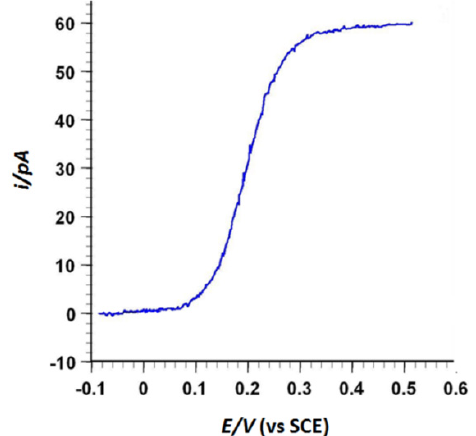
Figure 2. Steady-state voltammogram of the AFM-SECM-electrode in aqueous solution containing 1 mM ferrocenedimethanol and 0.1 M KH traces are superimposed. The potential scan rate was 50 mV s − 1